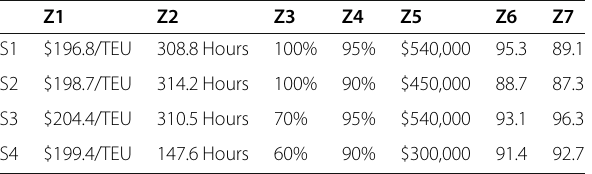
Table 12 Original Data of Four Alternatives of Feeder Network